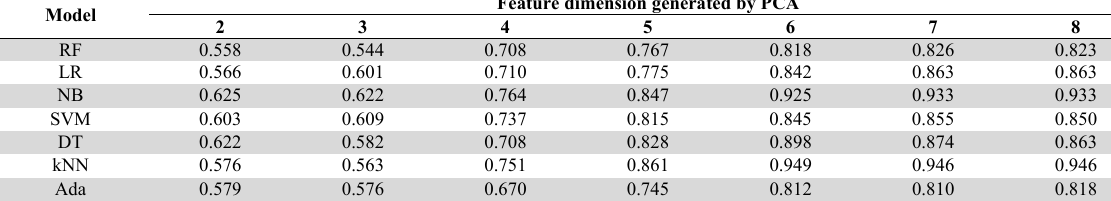
Results of Accuracy evaluation measure against different feature dimensions generated by PCA Model